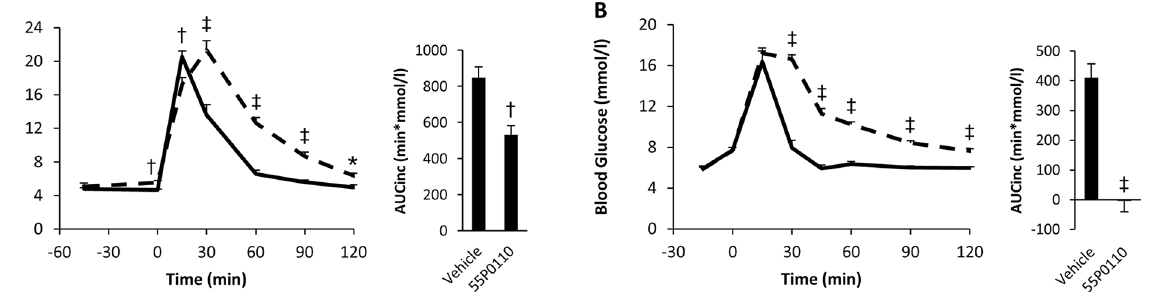
Fig 4. Improvement of glucose tolerance by 55P0110 is independent of the route of administration. Effects of 90 mg/kg 55P0110 (full lines) as compared to vehicle (broken lines) on glucose excursion and incremental area under the glucose curve (AUCinc) in intraperitoneal glucose tolerance tests (2 g/kg) in male C57BL/6J mice. ( A ) Glucose injected 45 min after oral administration of 55P0110. ( B ) Glucose injected 15 min after intraperitoneal injection of 55P0110. Means ± SEM; n = 7 – 9 each; * p < 0.05; † p < 0.01; ‡ p < 0.001 vs.